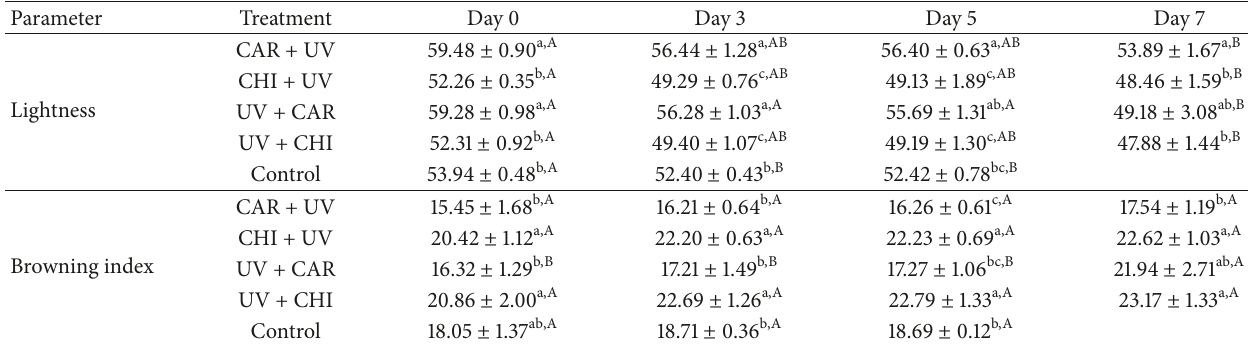
Table 3: The effect of different UV-C and edible coating combinations on surface lightness and browning index of longan